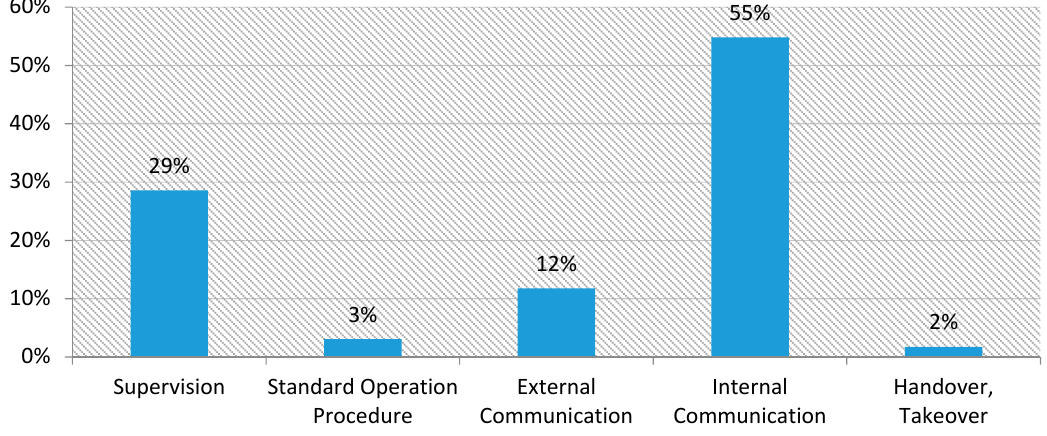
Figure 4. Task Error Category Percentages Platforms.